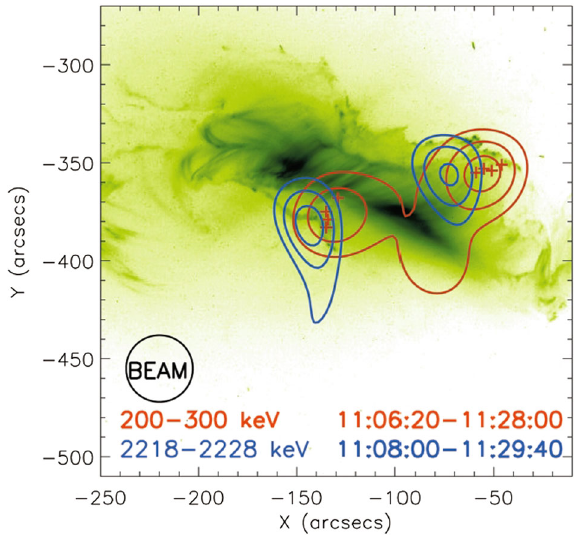
Fig. 23 Location of the gamma-ray sources of the flare SOL2003-10-23 observed by the RHESSI satel- lite. The contours at 50, 70, and 90% of the peak value show in blue the deuterium recombination line at 2.223 MeV and red the electron bremsstrahlung at 200–300 keV. The centroid positions of the bremsstrahlung emission at different times are indicated by plus signs. The FWHM angular resolution is 35 (cid:3)(cid:3) ,givenat bottomleft .TheRHESSIdataareoverlaidonthenegativeofaTRACE195Åimagedominated by the emission of Fe xii . Image reproduced by permission from Hurford et al. (2006), copyright by